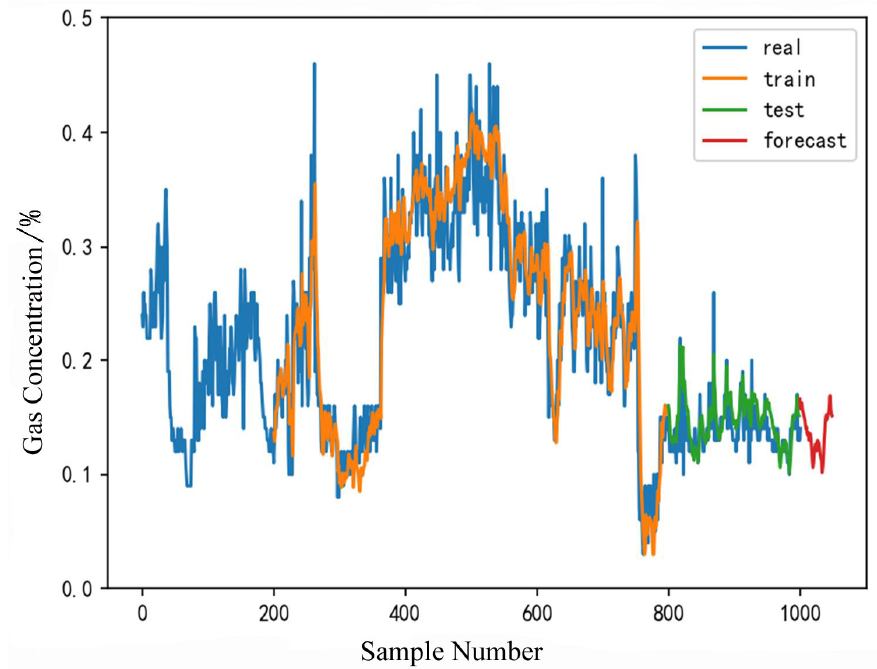
Figure 11. GRU prediction model fitting effect diagram.